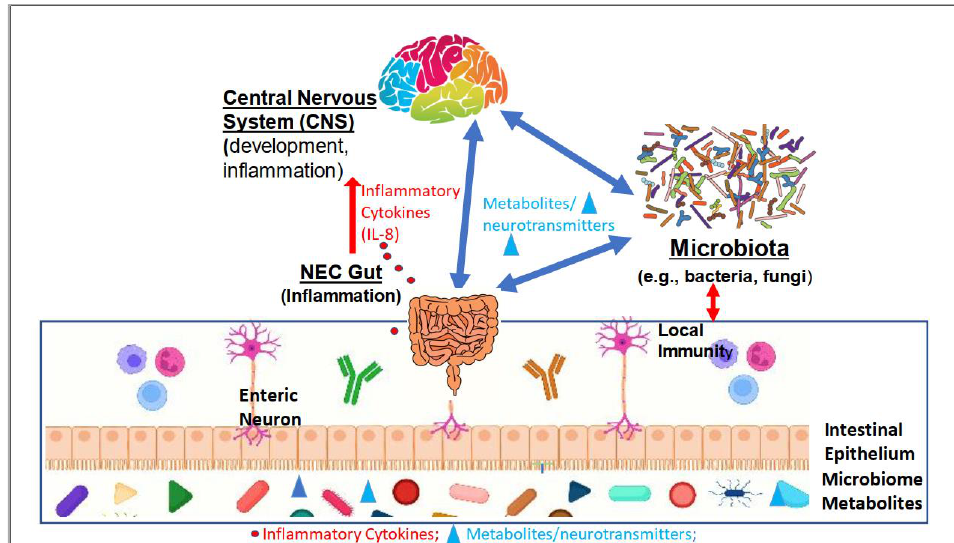
Figure 1. A working model of the gut microbiota–brain (GMB) axis in NEC. The interactions between the gut microbiota and brain are bidirectional. The balance between different microbiome taxa may result in dysbiosis, metabolite production, and inflammation that induce pathological changes in the gut and brain.